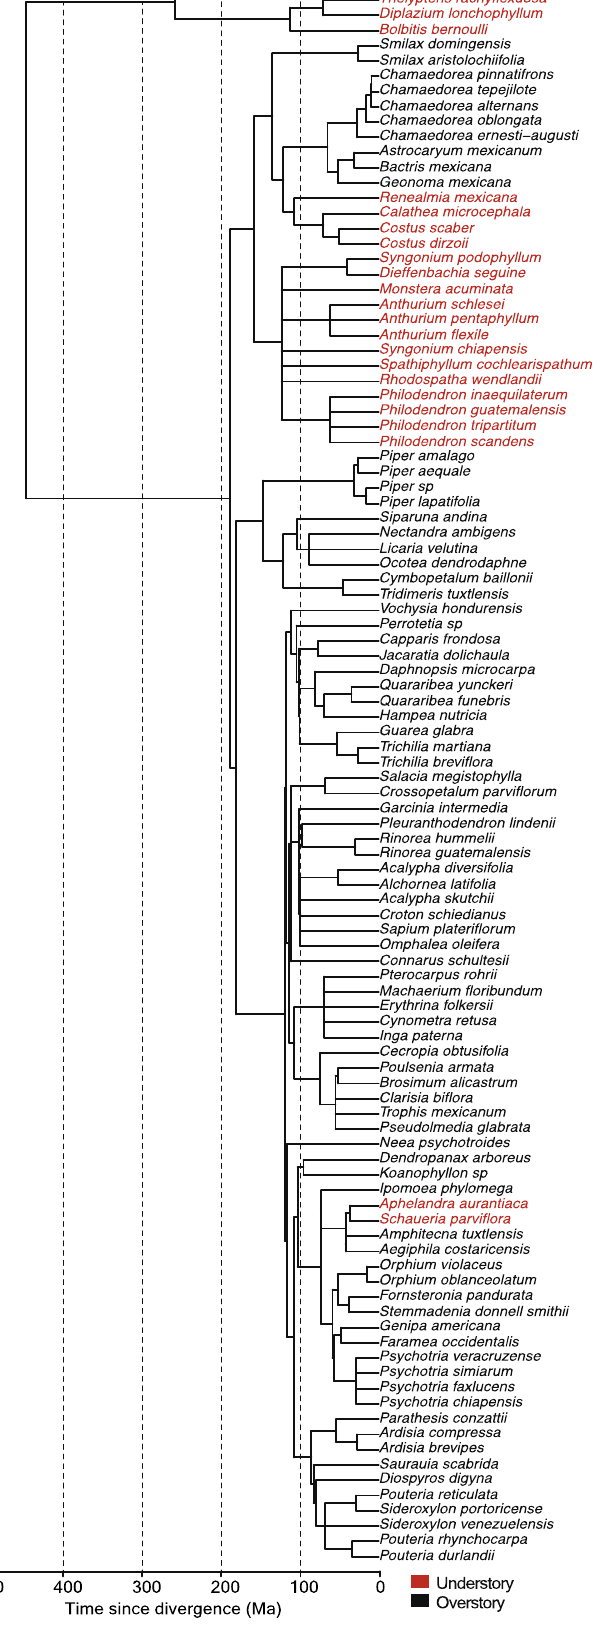
Figure 3. Phylogeny of all species encountered in the study, derived from Zanne et al. [27] for angiosperms, and Rothfels et al. [28] for ferns. See text for details.